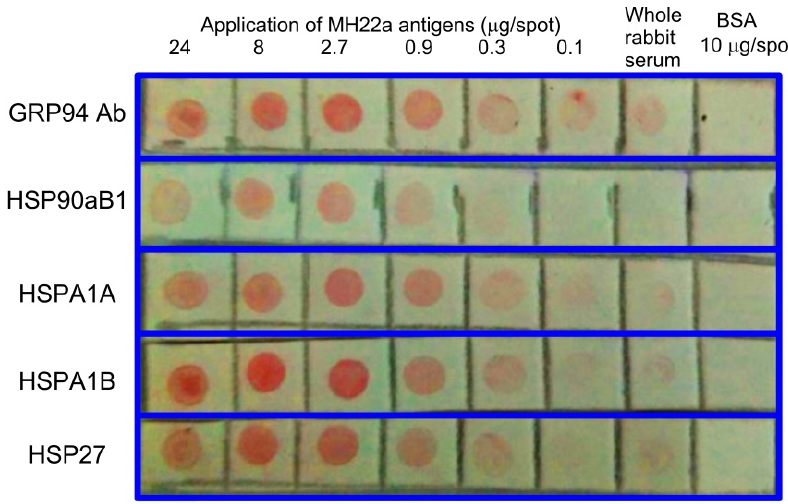
Figure 2. Identification of HSPs in the whole-cell lysate of MH22a by dot blot immunoassay.